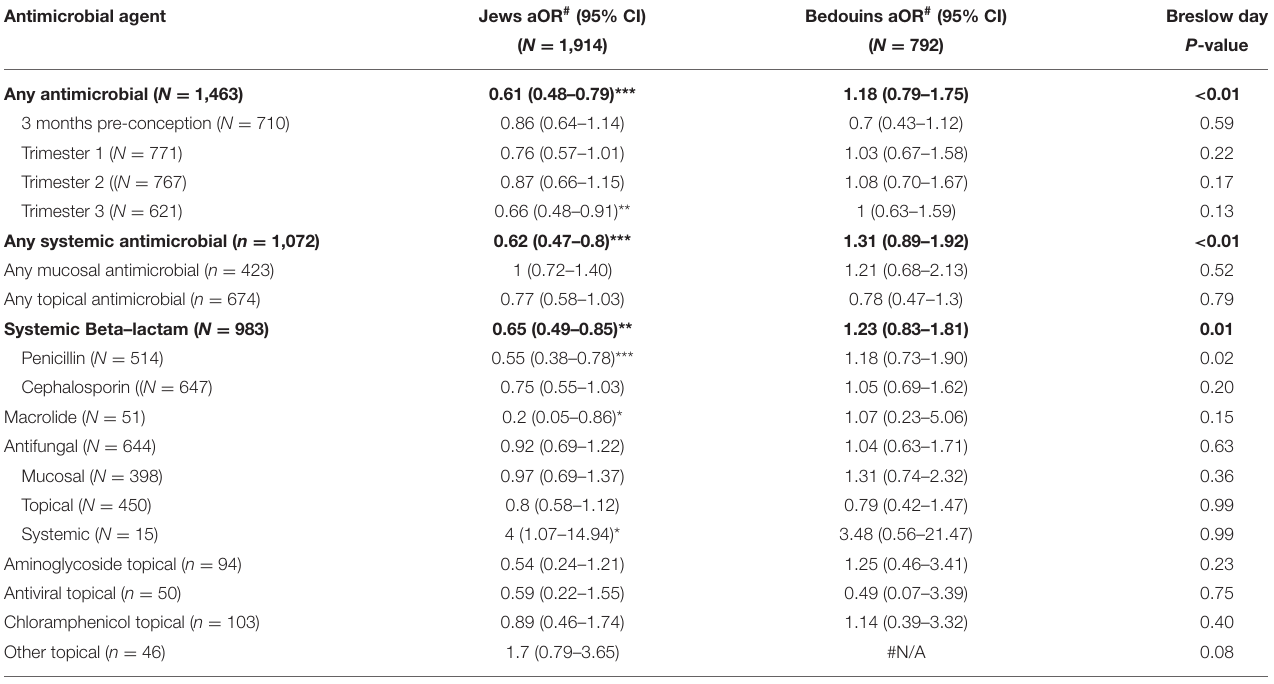
TABLE 4 | Adjusted ORs for ASD of different types of antimicrobial agents in a multivariate model including background characteristics, stratified by ethnicity. Antimicrobial